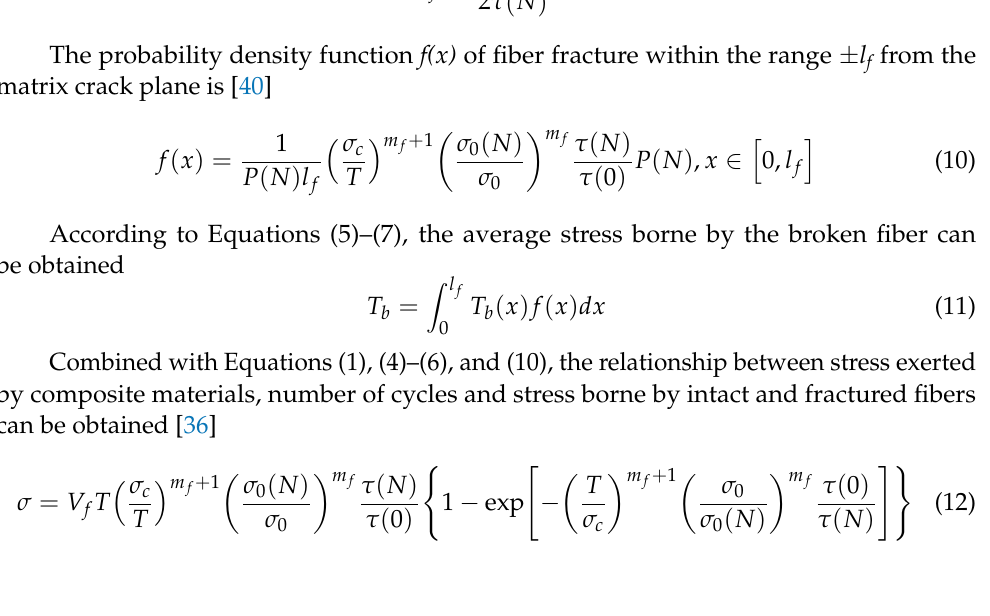
The probability density function f(x) of fiber fracture within the range ± l f from the matrix crack plane is [40]